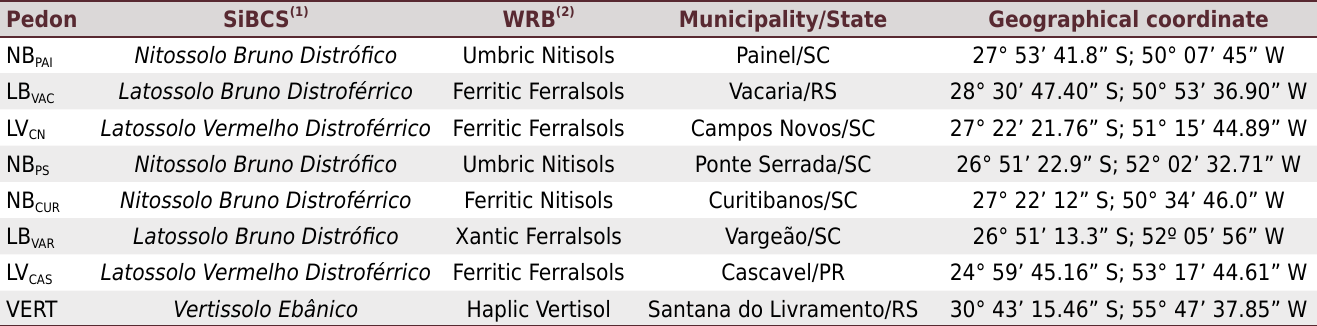
Table 1. Classification and location of soils studied